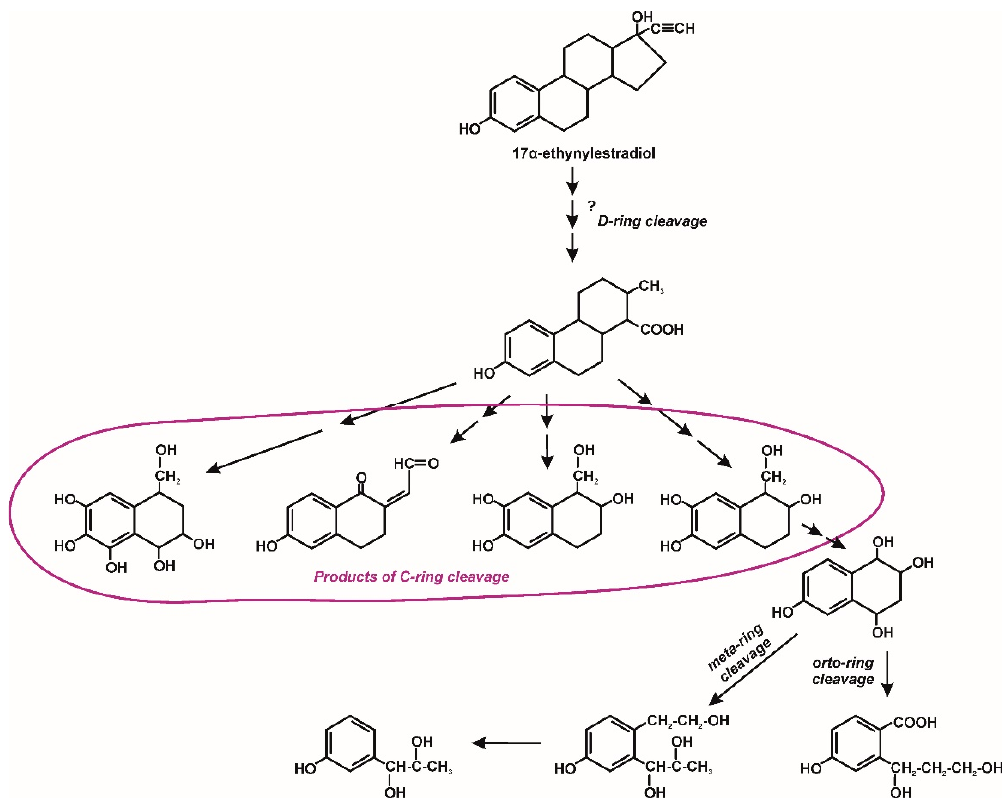
Figure 9. Proposed biotransformation mechanism of 17 α -ethynylestradiol by Lentinula edodes [44].